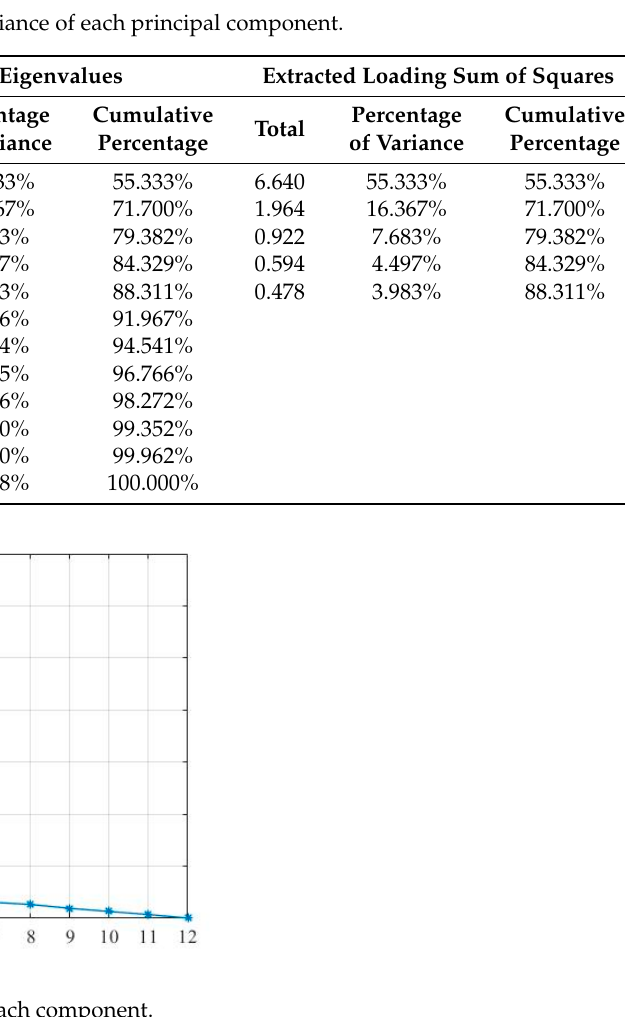
Figure 7. Characteristic value of each component.